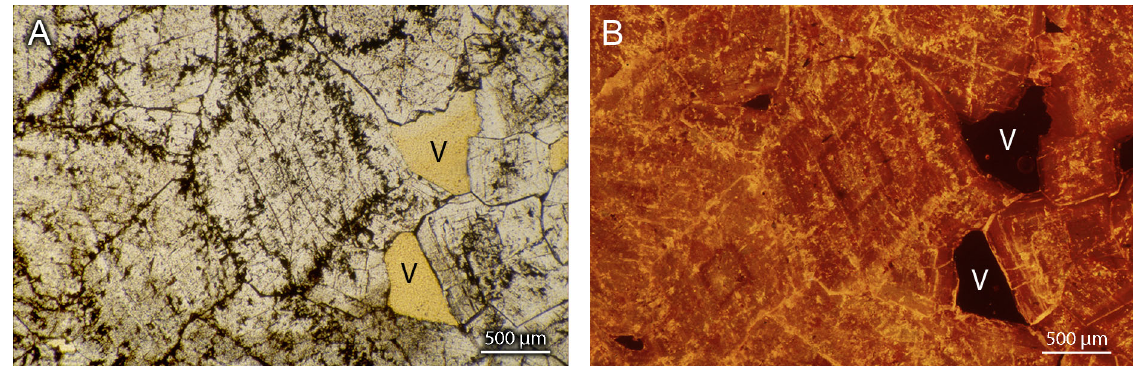
Fig. 12. Paired thin section photomicrographs of type 6 dolomite with vugs (V) in crossed polars ( A ) and cathodoluminescence ( B ). Hino drill core, 52.0 m, GIT 441-643.